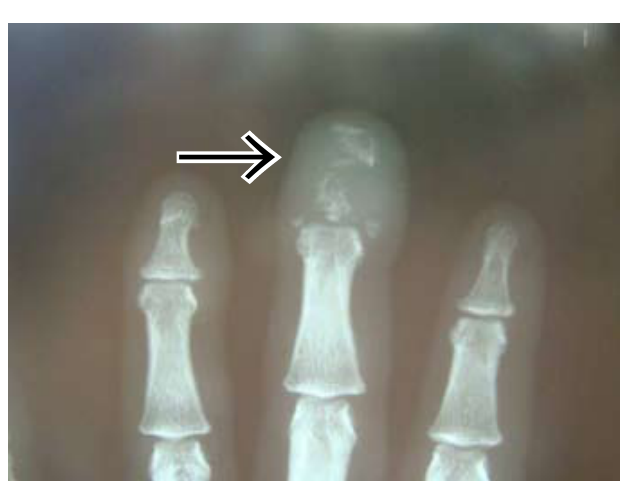
Fig. 17. Frontal X-ray of the terminal tufts with acreosteolysis owing to an overlying